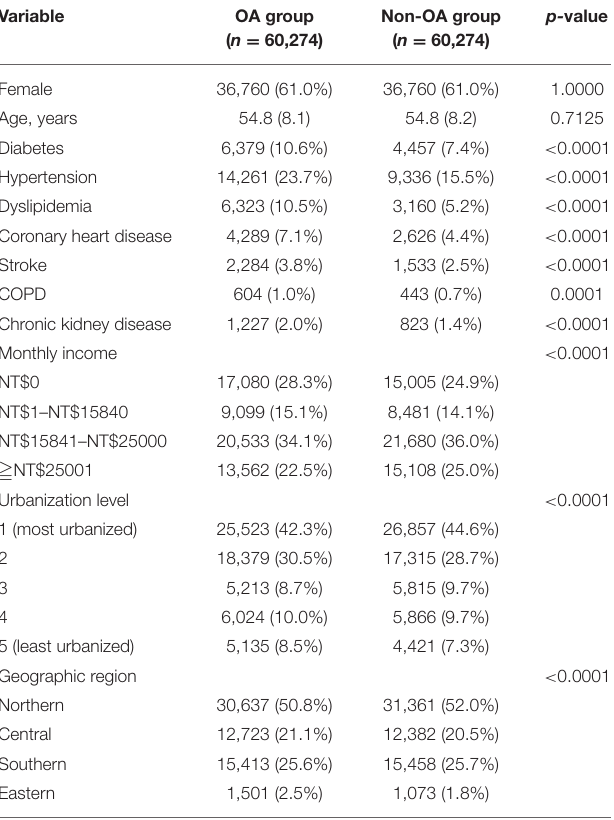
TABLE 1 | Baseline demographic and socioeconomic characteristics and comorbid conditions of the osteoarthritis (OA) and non-OA groups. Variable